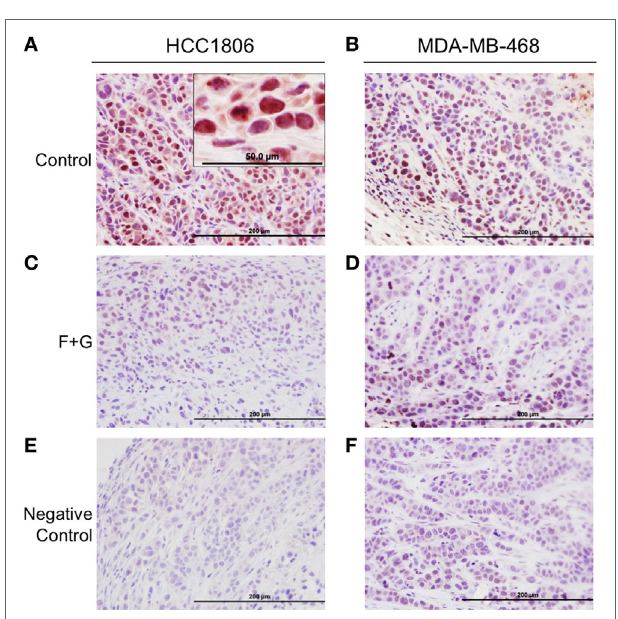
FigUre 2 | Insulin-like growth factor binding protein-3 (IGFBP-3) immunohistochemistry of HCC1806 and MDA-MB-468 tumors. (a,B) Representative IGFBP-3 staining of each tumor type from control mice, showing strong nuclear localization. (c,D) Representative IGFBP-3 staining of each tumor type from mice treated with fingolimod + gefitinib (F + G). (e,F) Negative control staining—non-immune rabbit serum at the same dilution as IGFBP-3 antiserum. Bar = 200 µm. Inset: higher magnification of HCC1806 section from control tumor. Bar = 50